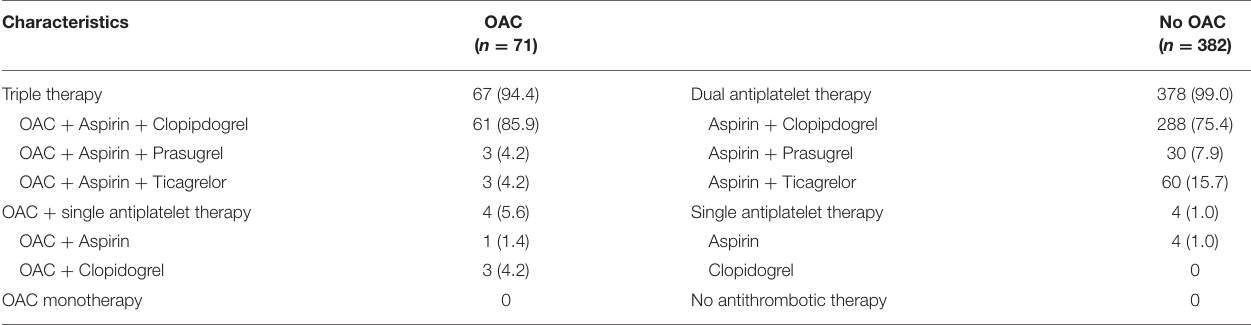
TABLE 2 | Detailed information on antithrombotic therapy. Characteristics